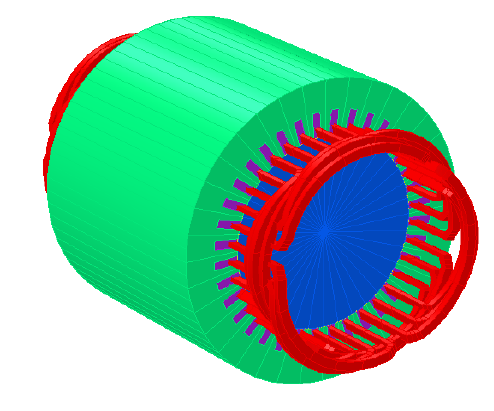
Figure 13. Model of the induction machine magnetic circuits and